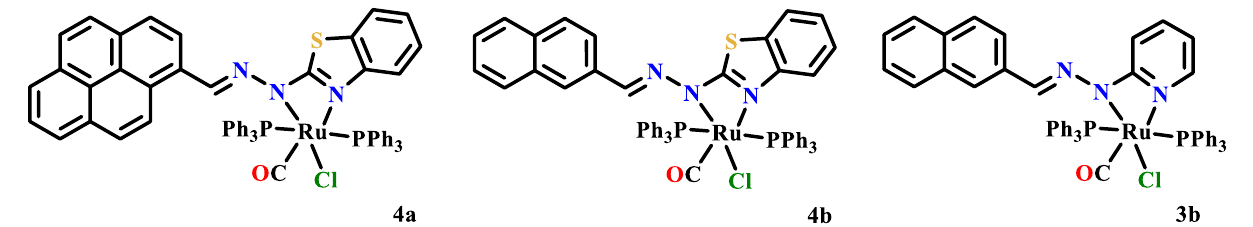
11 of 58 Figure 10. Three ruthenium(II) complexes of naphthalenehydrazone with α -furfuraldehyde amidyl thiourea. The similar coordination pattern for the ruthenium(II) complex of naphthylhydra- zone was reported by Soumitra Dinda et al. [61]. The naphthylhydrazone ligand in this work used benzothiazole or pyridine as the side chain, but this naphthylhydrazone ligand did not contain 2-OH, something that is relatively rare among existing studies (Figure 11). It was confirmed by X-ray single-crystal diffraction analysis that the ligands of these com- plexes were all electron donors to Ru(II) through N , N ′ -bidentate chelation, but the coor- dination N atom in this work was not from azomethine-N, but was instead from the deprotonated -NH groups of the hydrazone, which was attributed to the more flexible acylhydrazone. The C=O group and Cl − combined with the two N atoms to form the equa- torial plane of the Ru(II) coordination octahedron, while the two PPh 3 occupied the axial position. Multiple transitions in the electron spectra of complexes can also be explained by the time-dependent density functional theory (TDDFT). The antibacterial activities of the Ru(II) complexes were tested in vitro for up to 12 typical pathogens. The results